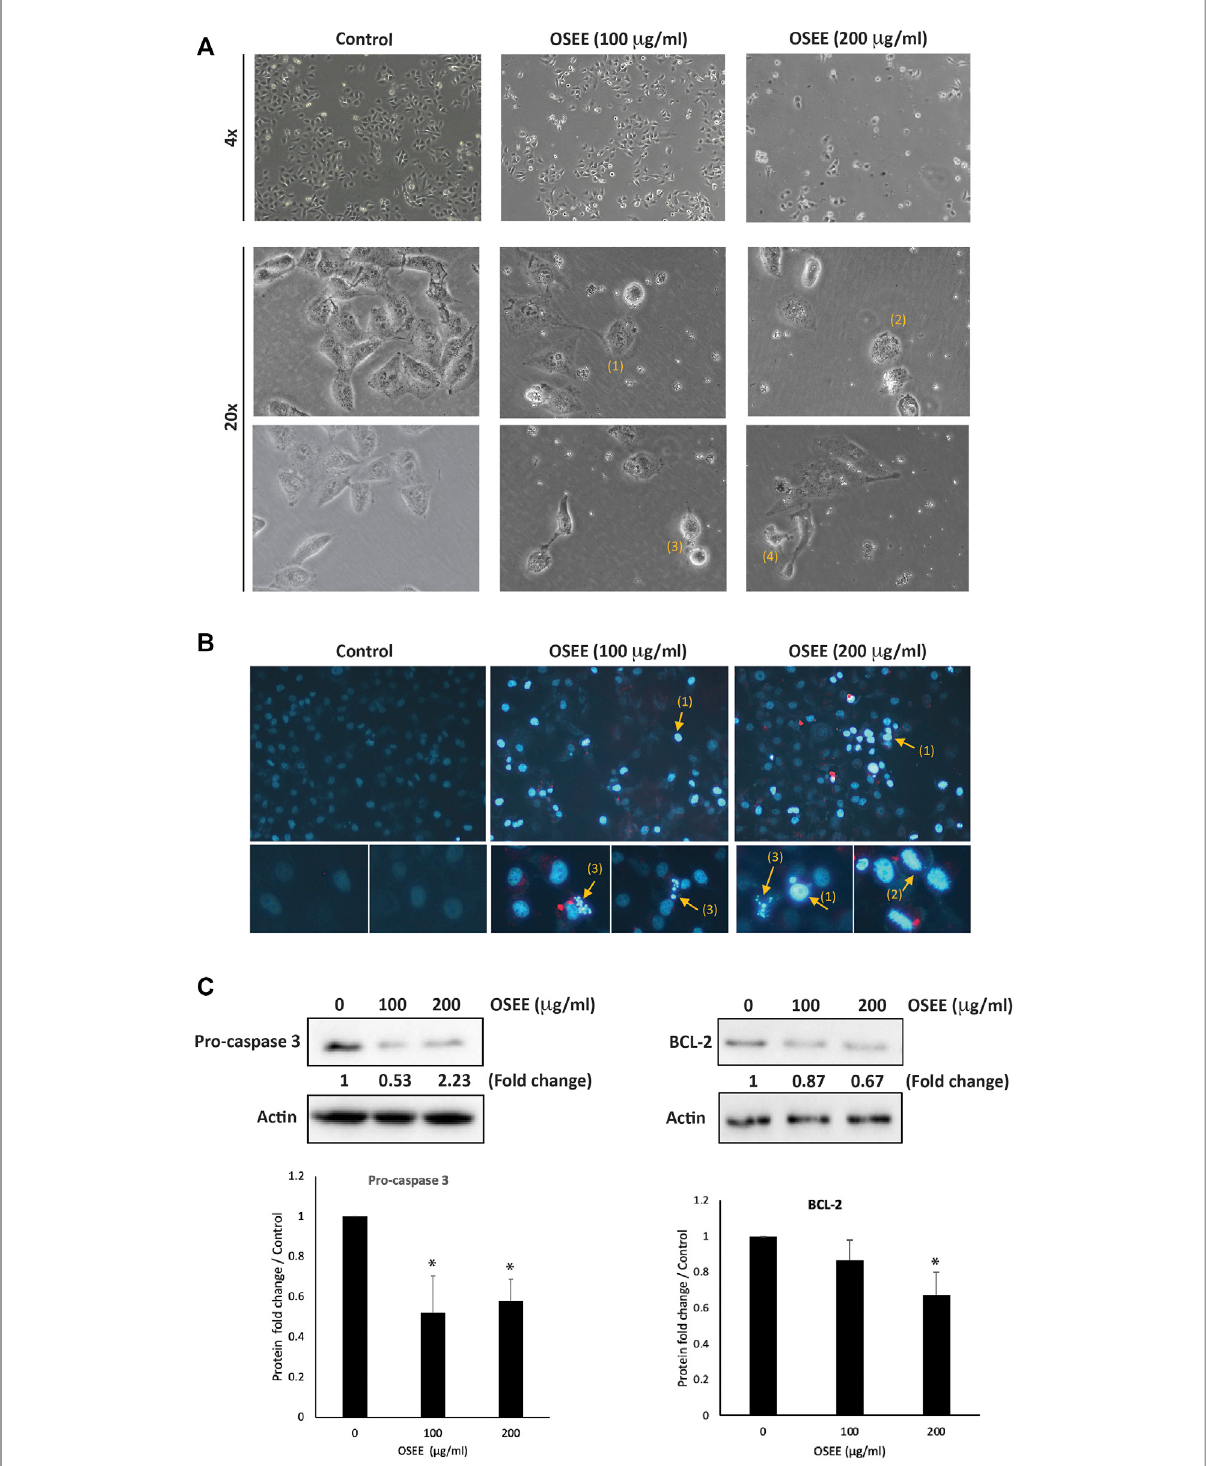
FIGURE 5 O. syriacum induces apoptosis in MDA-MB-231 cells. (A) MDA-MB-231 cells were treated with and without the indicated concentrations of OSEE for 24 h. Morphological changes were observed by light microscopy. Arrows show (1) cell shrinkage, (2) membrane blebbing, (3) apoptotic bodies, and (4) echinoid spikes. (B) Cells were incubated with OSEE at the indicated concentrations for 24 h and stained with 4 ′ ,6-diamidino-2-